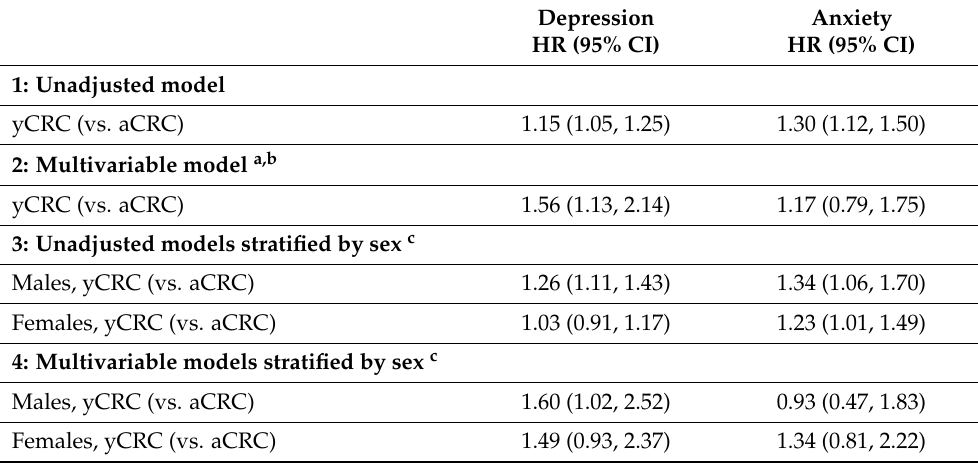
Table 3. Risk of depression and anxiety in individuals diagnosed with young-onset colorectal cancer (yCRC; <50 years) compared to those with average-age-onset colorectal cancer (aCRC; ≥ 50 years) adjusting for stage of CRC (2010–2016).